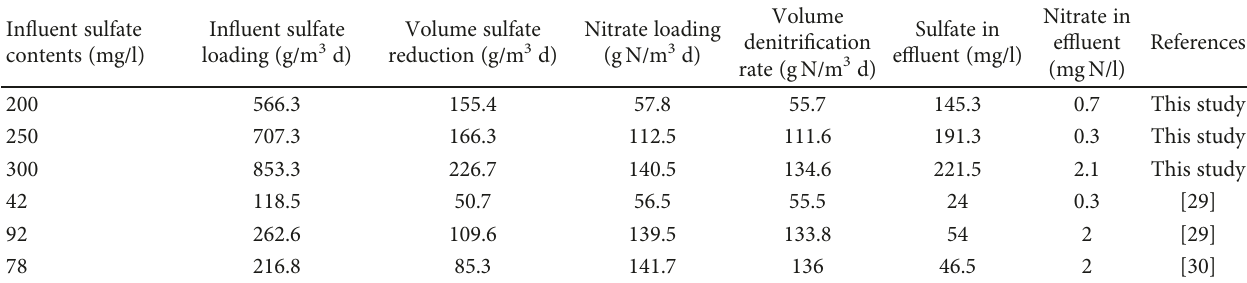
Table 4: The in fl uent loadings and volume reductions for nitrate and sulfate under di ff erent in fl uent sulfate concentrations. In fl uent sulfate